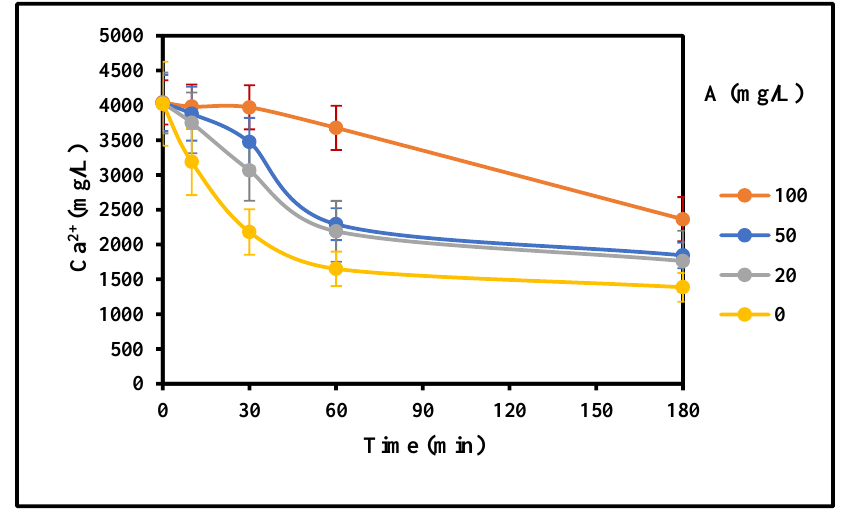
Figure 8. Effect of inhibitor A concentration on the rate of gypsum crystallization with mixing (4000 mg/L CaSO 4 (as Ca), 0 g/L gypsum seed, 4 g/L Fe 3+ , 0 – 100 mg/L Inh. A, 25 °C, stirring rate: 200 rpm; Stirring time (min): 180/180).